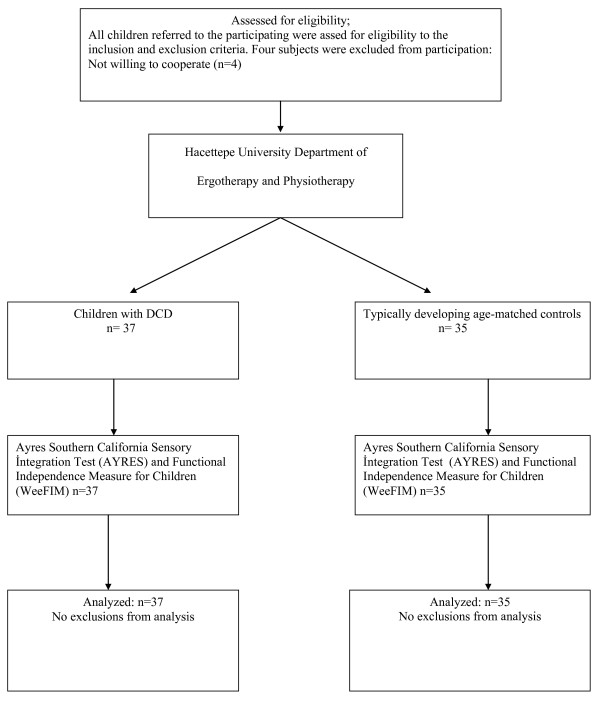
Standard flow chart of the study.